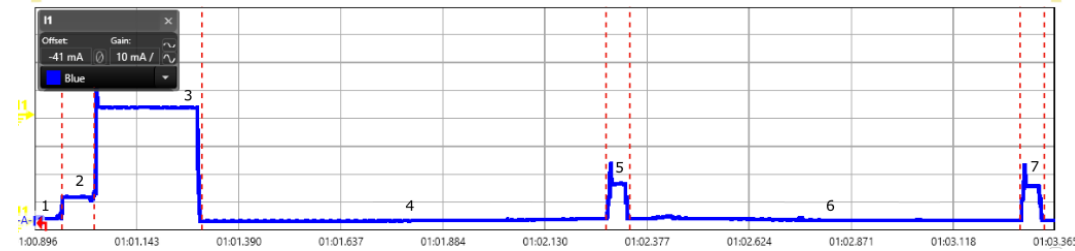
Figure 8. Scope view of a LoRaWAN message (Class A device) captured using power analyzer for the measurement of energy consumption. Table 1. Current composition split into different states of operation for